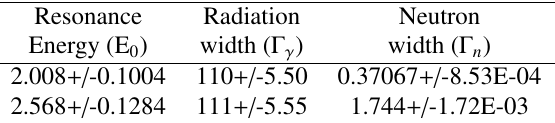
Table 1. Resonance parameters and their uncertainties.